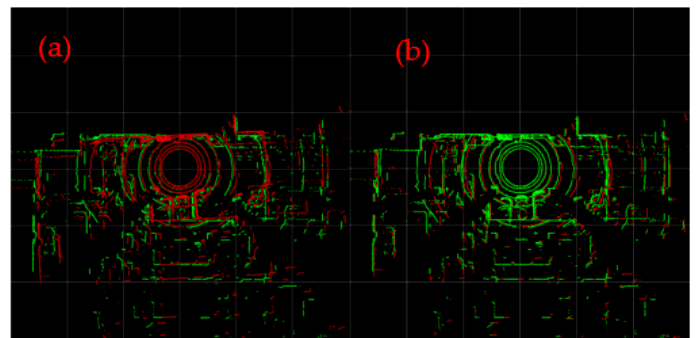
Figure 10. The loopback frames at the entrance of the parking lot and the point cloud of current frame is in green, while the historical loopback frame is in red. ( a ) Detection by the loopback algorithm of LeGo-LOAM itself; ( b ) detection by scan context.